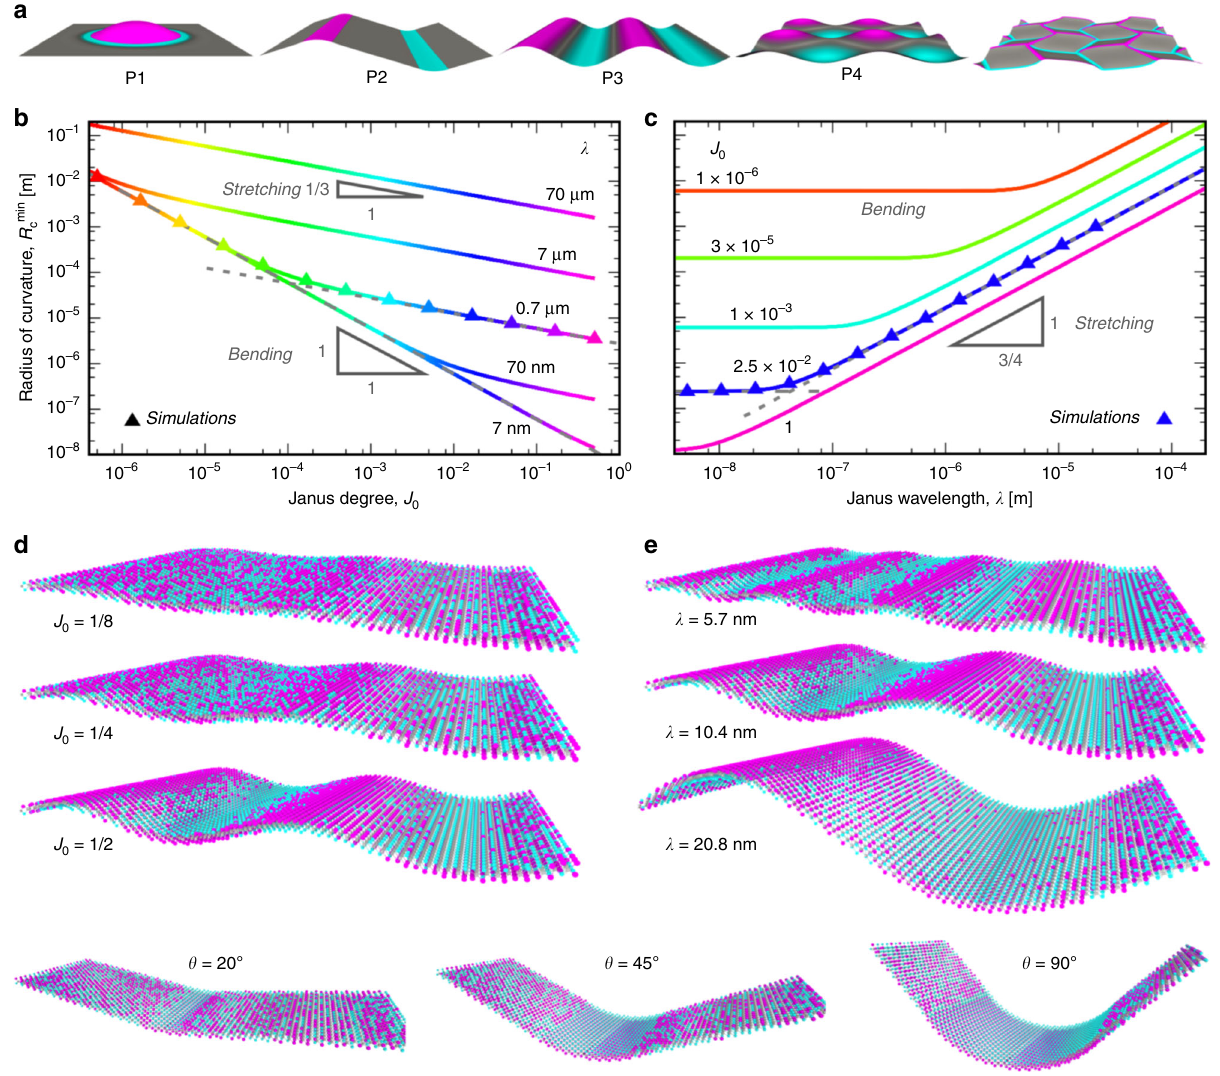
Fig. 4 Composition ! shape programming: 2D MoSeS monolayers that self-assemble into 3D shapes. a Topographies generated by the composition patterns displayed within each monolayer (also see Supplementary Movies 1 – 5). The composition patterns J ð x ; y Þ for P1 – P4 were generated using the expressions for bending-dominant composition ! shape programming given in Table 1. Janus pattern color maps are scaled by their respective maxima J 0 . b , c The minimum radius of curvature R min c for the sinusoidal pro fi le P3 in a as a function of b Janus degree J 0 and c Janus wavelength for several values of λ and J 0 , respectively. The solid lines, dashed lines, and symbols are the full analytic result (see Methods), the asymptotic expansions in Table 1, and simulation results, respectively. Line colors correspond to Janus degree in both ( b ) and ( c ). d , e Atomic representations of the equilibrium shapes and compositions for MoSeS ( (cid:1) c ¼ 1 = 2) with 1D sinusoidal Janus patterns (P3) for several choices of d Janus degree ( J 0 at λ ¼ 10 : 4 nm) and e wavelength ( λ at J = 2), and f with 1D J = 2 Janus strips (P2) of width L ¼ 1 : 9, 5.8, and 11.6 0 ¼ 1 0 ¼ 1